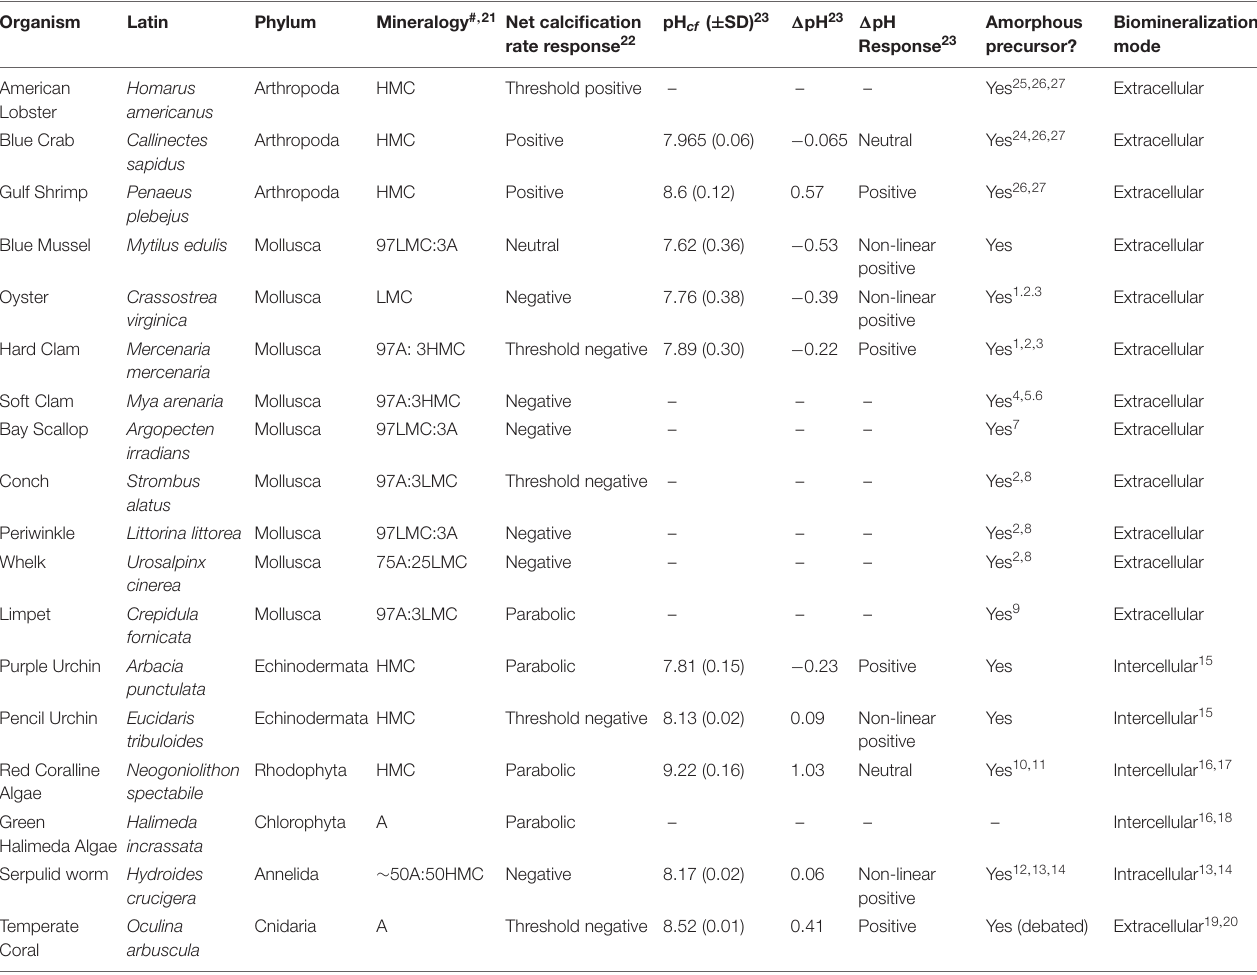
TABLE 1 | Species examined in this study with supporting